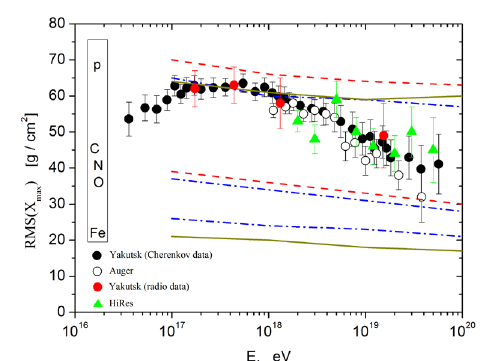
Figure 3. Fluctuations in the depth of the maximum of EAS Figure 2. The dependence of X max on energy, obtained from ob- Figure 1. The plan of the Small Cherenkov Array. Placement of development in the energy range 3 servations of Cherenkov radiation for the period 1974-2014. and the charged particles detectors, muon detectors, and Cherenkov tions for the QGSjet-01 [16], QGSjetII-04 [17] and EPOSv1.99 1994-2010, at the Yakutsk array of the EAS. Comparison with light detectors models for primary protons, CNO nuclei (models QGSjet-01, QGSjetII-04) and iron nuclei. Comparison also with the data of Auger [18] and HiRes [19, 20]